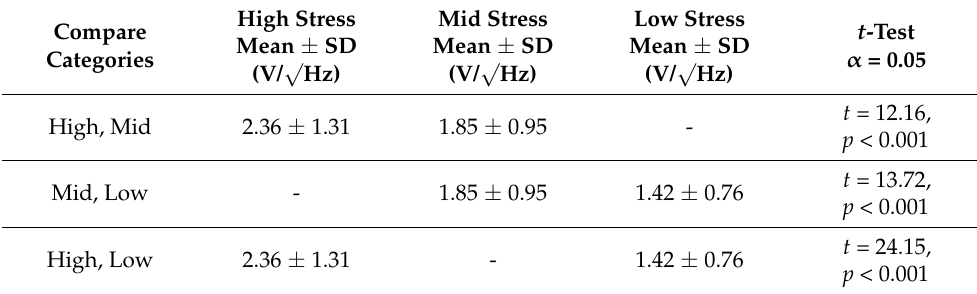
Table 8. Independent sample t -test on the O1_HighGamma